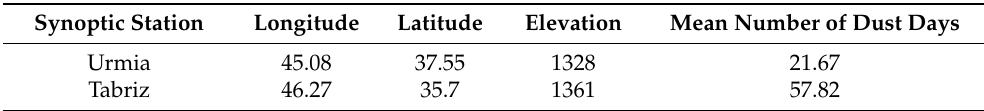
Table 2. The two synoptic weather stations around Lake Urmia and the mean annual number of dust days during